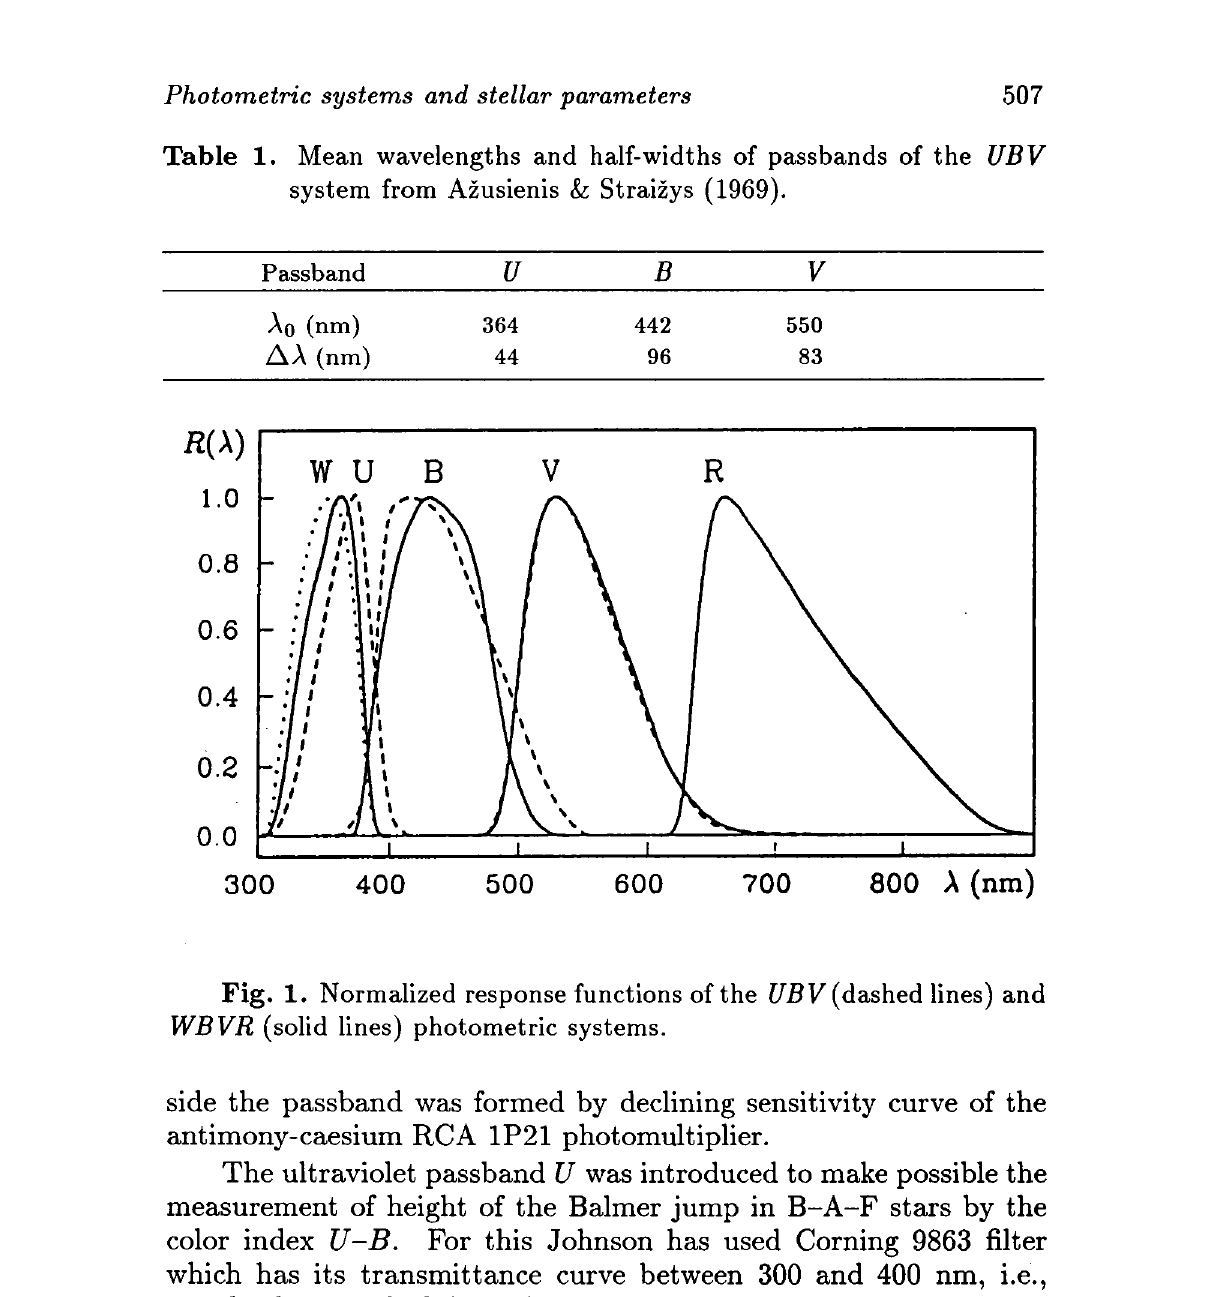
Table 1. Intrinsic color indices ( U — B) o and ( B — VQo, the ratios of color excesses Ejj-b/Eg-v, the ratios of interstellar extinction to reddening Ay/Eg-v and the interstellar reddening-free